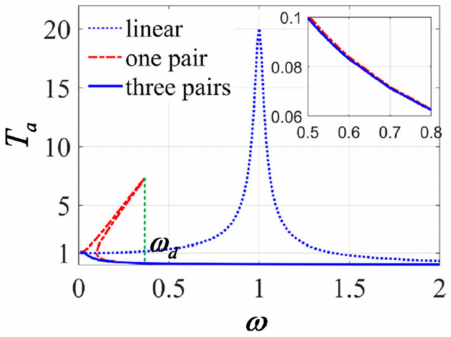
Figure 10. Comparison of vibration isolation performance of the multi-spring vibration isolator studied by Zhao et al. [9] with that of a linear vibration isolator and a typical QZS vibration isolator. Figure adapted with permission from Ref. [9]. Copyright 2021, copyright Zhao, F.